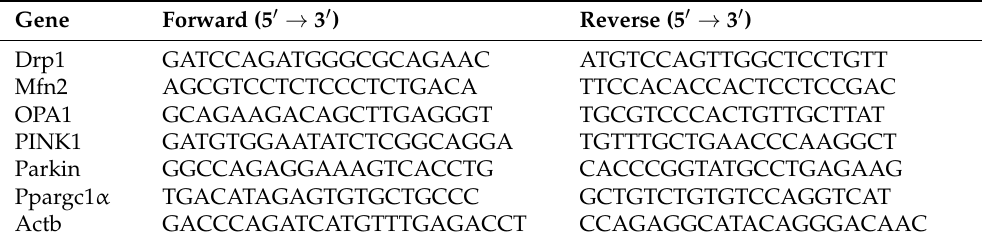
Table 5. List of gene-specific primers for the real-time PCR